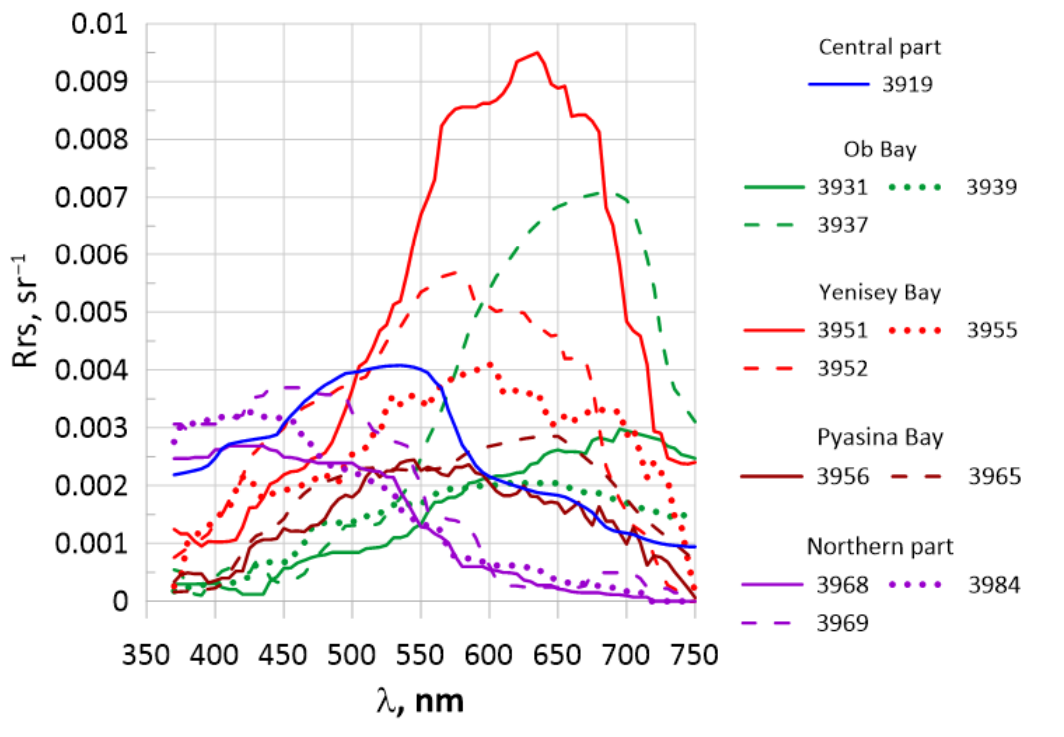
Figure 4. Measured spectra of in situ remote sensing reflectance in the 58th cruise of the R/V “Academik Ioffe” .